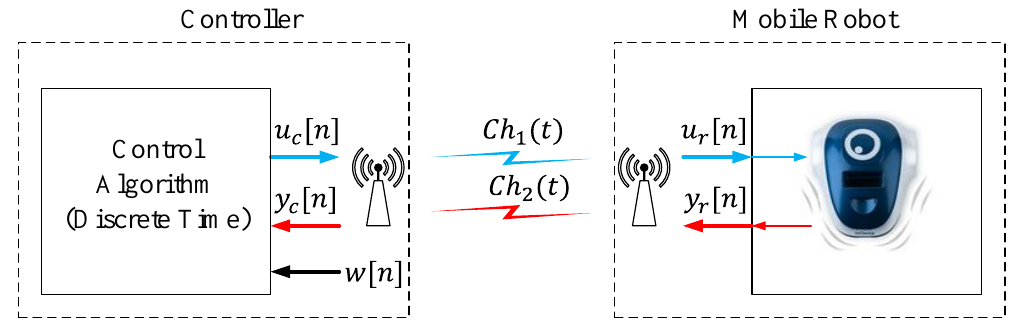
Figure 2. Wireless discrete-time control.